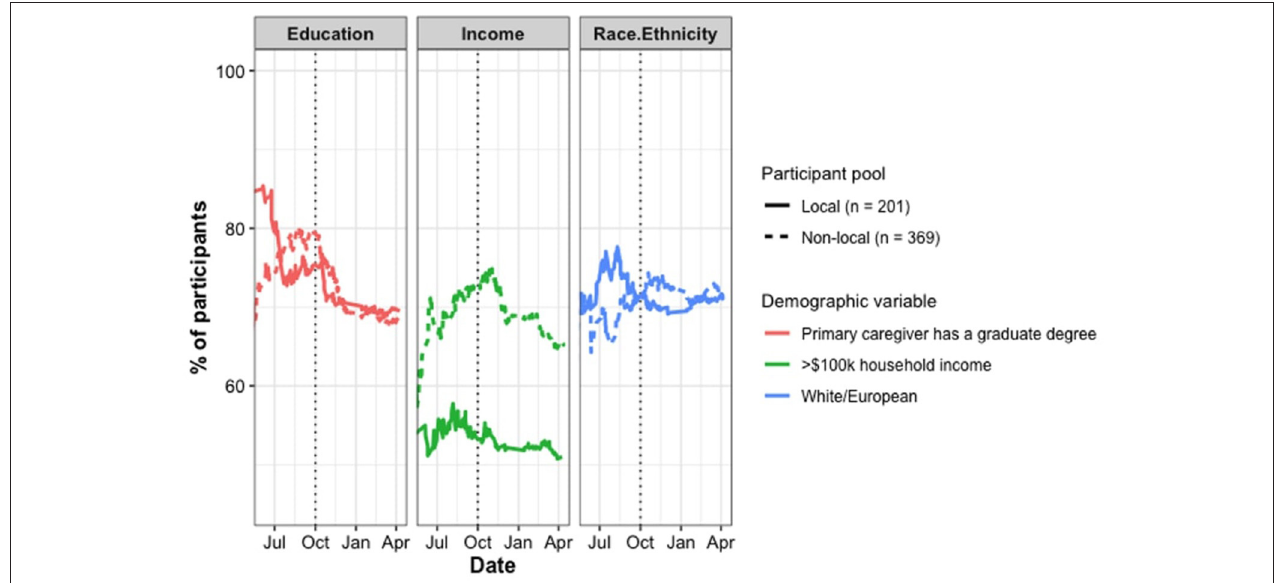
FIGURE 2 | Demographic indicators among local and non-local participants (June 2020–April 2021). The time series graph show the percentage of participants (starting n = 30 local, n = 36 non-local) whose primary caregiver has a graduate degree (left, red), whose anual household income is greater than $100,000 (center, green), and who are white/European (right, blue). Solid lines indicate trends for local participants and dashed line indicate trends for non-local participants. High numbers on the y-axis indicate higher income, higher education, and perdominantly white samples. The checked vertical line signifies the date of our lab meeting in October 2020, when we set new goals for reaching more participants outside of academic families.